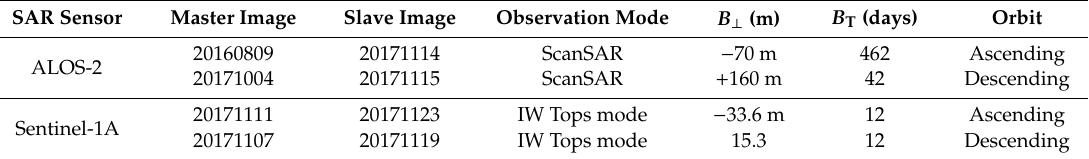
Table 1. The parameters of selected SAR